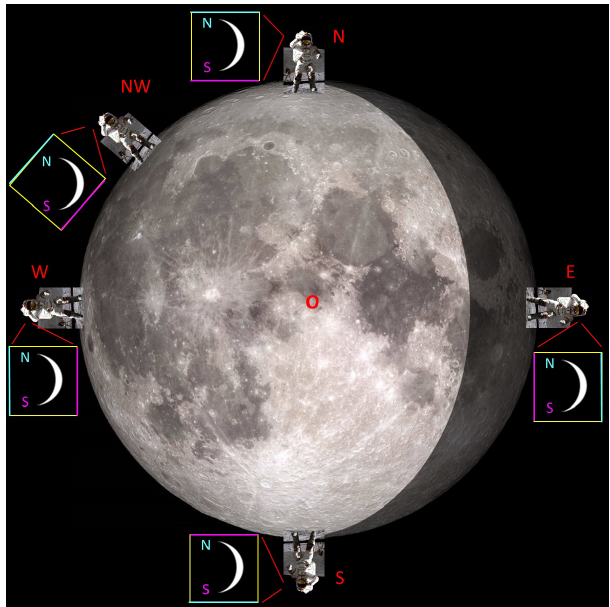
Figure 6. Observers in different points of the Moon’s visible hemisphere. Image of the Moon – LRO (NASA, GSFC, Ari- zona State University) https://www.nasa.gov/feature/goddard/2020/ moon-more-metallic-than-thought (last access: 18 March 2023). Observer: photo of John W. Young, commander of the Apollo 16 lunar-landing mission (NASA). It is shown how, from the point of view of different observers on the Moon, the crescent of the Earth is oriented, indicating the Earth’s poles. The yellow squares (with blue top and violet bottom lines) show the astronaut’s vertically ori- ented field of view (FOV) and the crescent of the Earth that they see in this FOV (or in frame of the